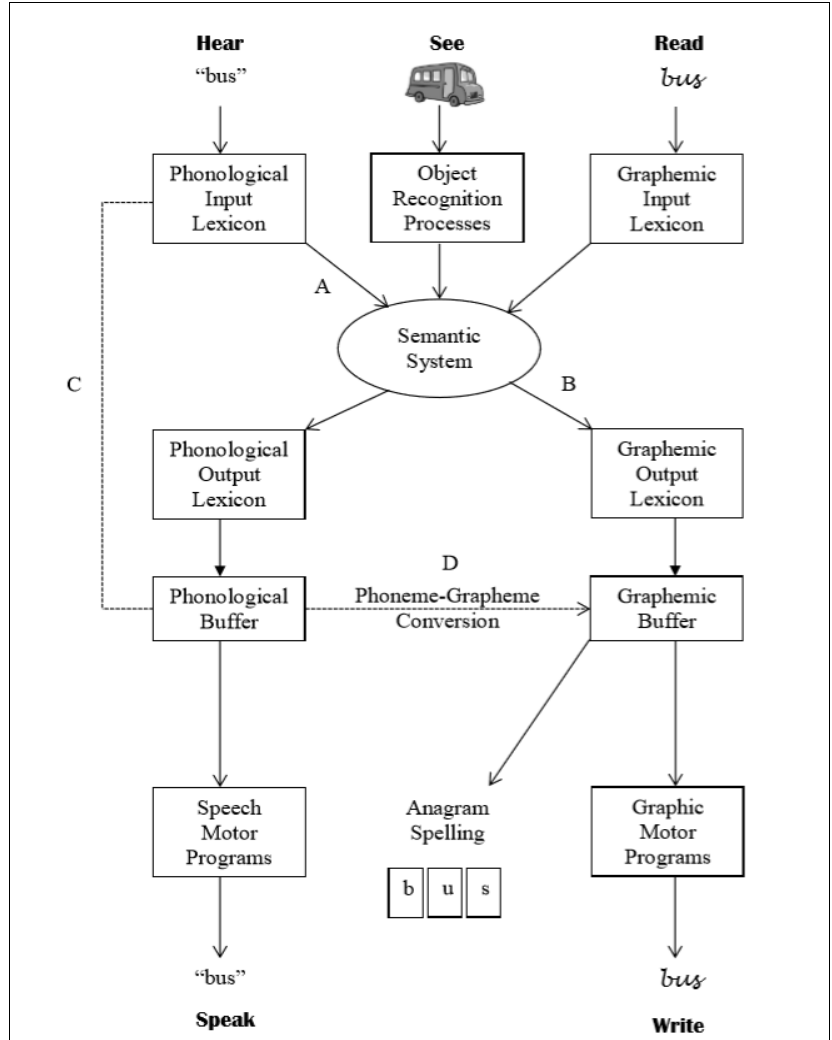
Figure 1. Cognitive processing model of language processing.